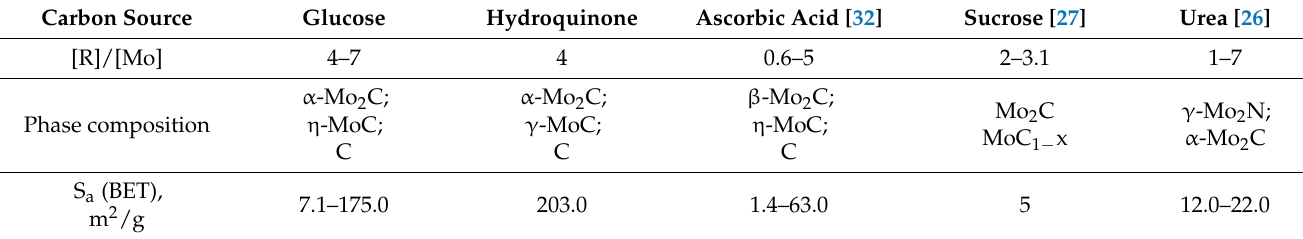
Table 3. Phase composition and BET surface area of molybdenum carbide with different liquid carbon sources. Carbon